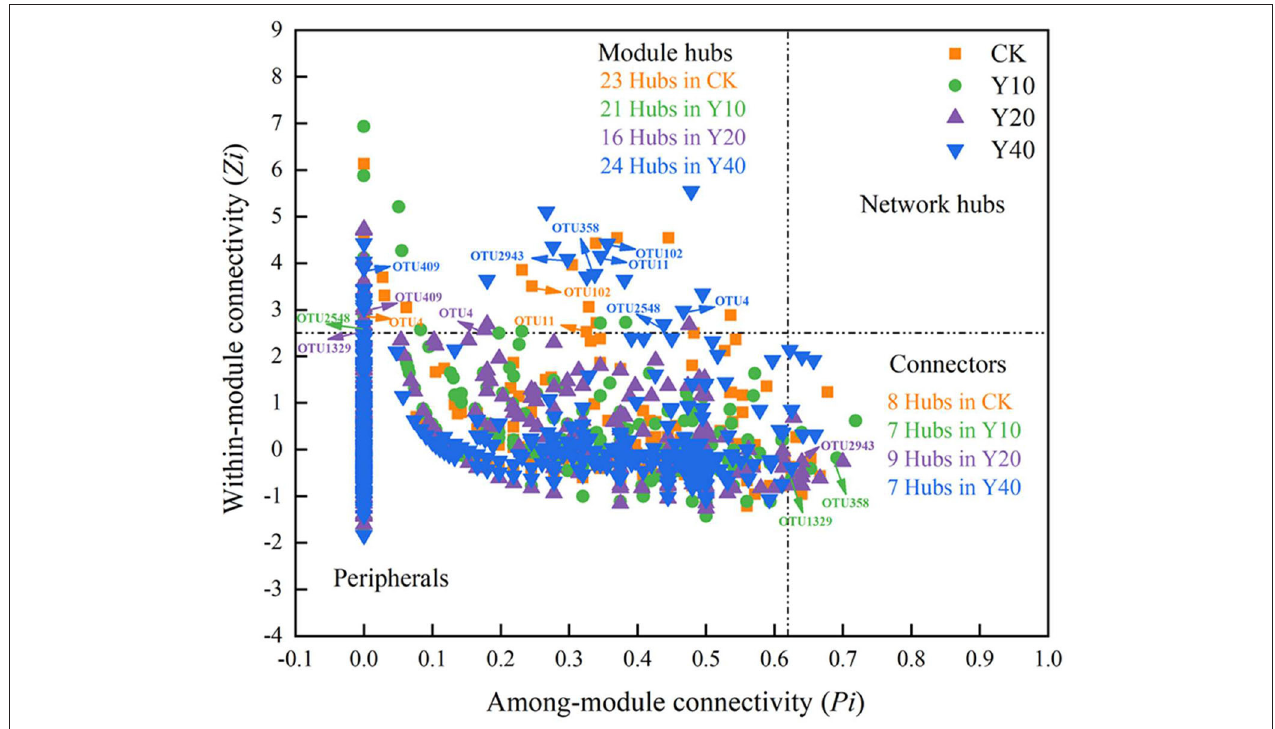
FIGURE 6 | Each node was identification to classify the keystone taxa in molecular ecological networks of bacterial communities. Each symbol represents an OTU from the network of CK, Y10, Y20 and Y40. The value of Zi and Pi confirmed each OTU’s topological role. Nodes were identified into four models depended on their Zi and Pi values: module hubs (Zi > 2.5 and Pi < 0.62), network hubs (Zi > 2.5 and Pi > 0.62), connectors (Zi < 2.5 and Pi > 0.62) and peripherals (Zi < 2.5 and Pi < 0.62). Besides, the number of module hubs and connectors as well as the OTUs that repeatedly appear in different networks were shown in the corresponding area of the